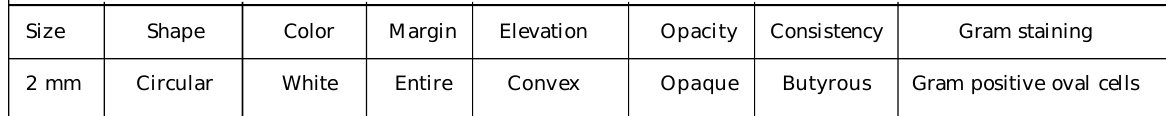
Table 2 : Colony characteristics of an isolated colony from Sabouraud’s agar plate